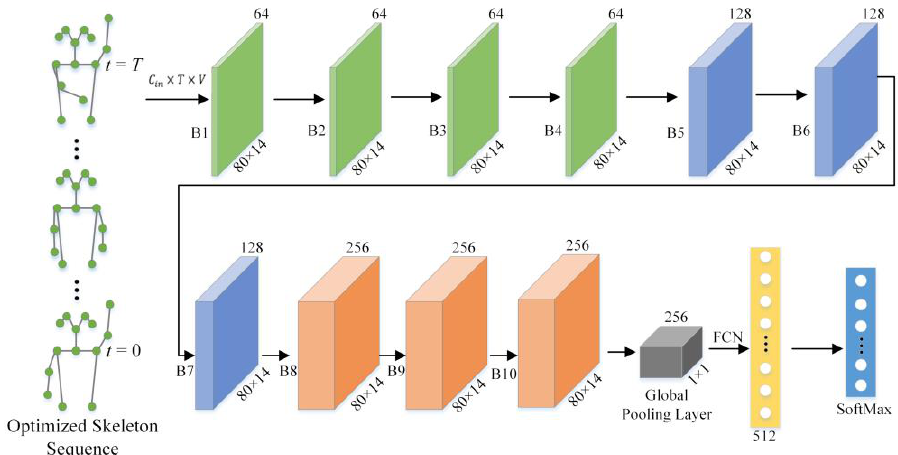
Figure 5. The architecture of the MD-GCN classification network.